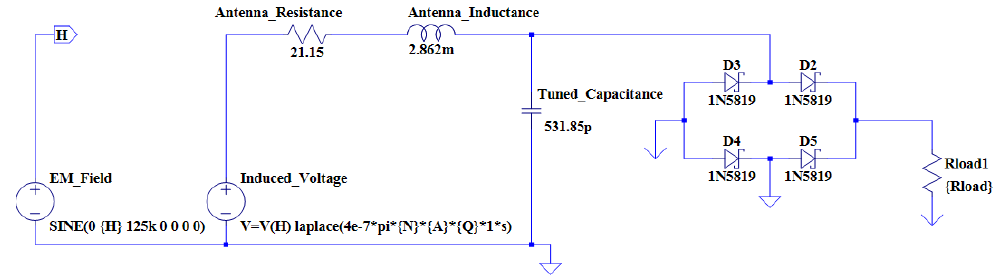
Figure 5. The simulation model of the LC tank and rectifier circuit.